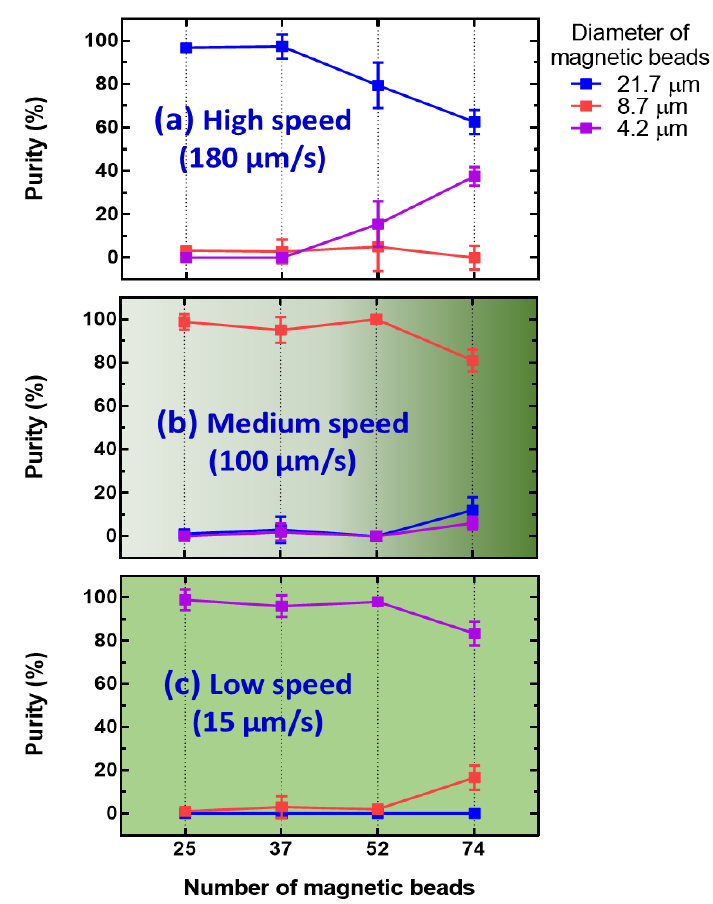
Figure 4. The purity of separation results for magnetic beads mixed with three different diameters and various total numbers by using speed sequence during the manipulation of ( a ) 180, ( b ) 100, and ( c ) 15 μm/s.